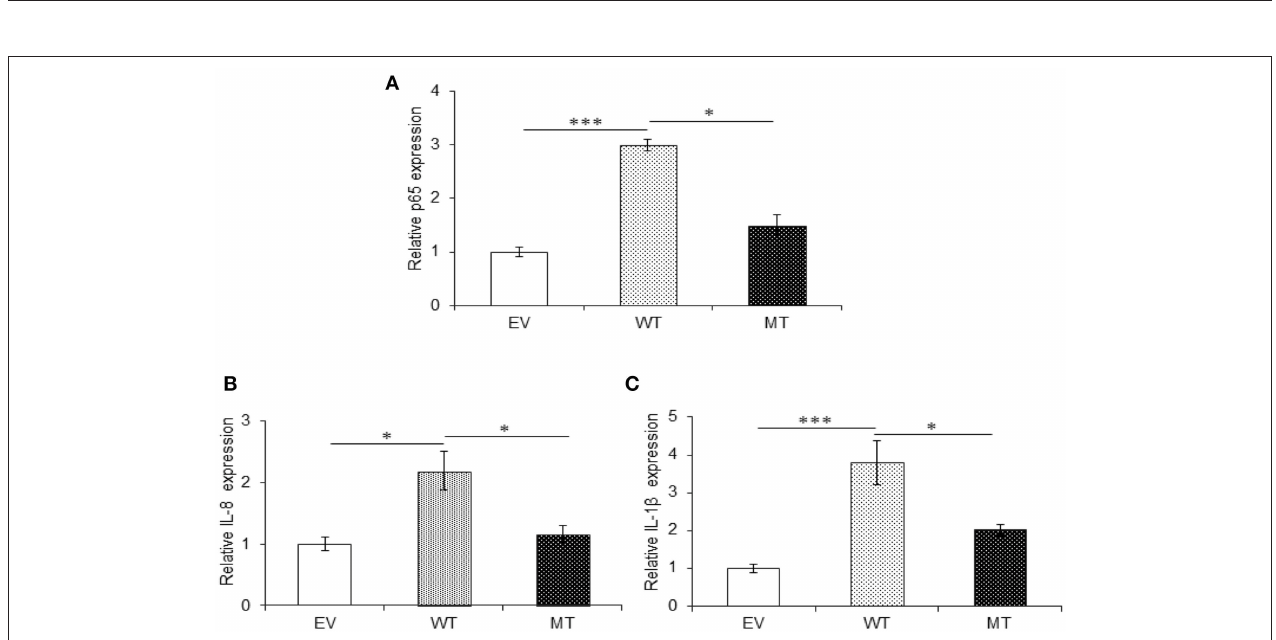
FIGURE 9 | Absence of TRAF6 results in higher pro-inflammatory response. miR-125b and TRAF6 were co-transfected in HT29 cells for 48h and stimulated with 100ng/ml of LPS. After 6h of stimulation, RNA was isolated and reverse transcribed to investigate the mRNA expression of p65, IL-8, and IL-1 β through qRT-PCR. p65 (A) , IL-8 (B) , and IL-1 β (C) showed significant higher expression in cells transfected with miR-125b, which negatively regulates the expression of TRAF6 gene while the presence of mutated form of miR-125b resulted in marked decrease in their expression. GAPDH gene was used as an internal reference. P < 0.05 were statistically significant. Significance was estimated with respect to the pBABE-puro empty vector control group. * p ≤ 0.05, *** p ≤ 0.001. Bars represent standard error of the mean (SEM).